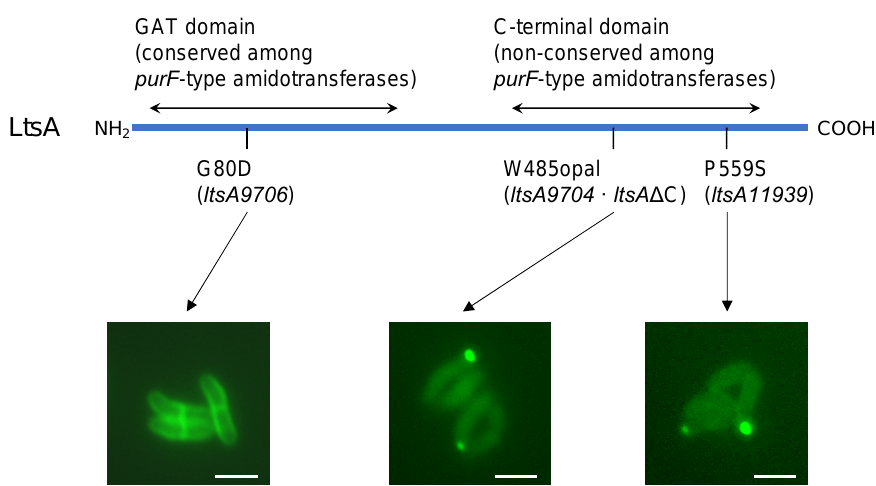
Figure 2. Intracellular localization of GFP-fusion of mutant LtsA proteins in C. glutamicum cells. In this figure, KY9714 cells expressing ltsA9706-gfp , lts AΔC -gfp , and ltsA11939-gfp gene fusions, respectively, are shown. Bars represent 2 µ